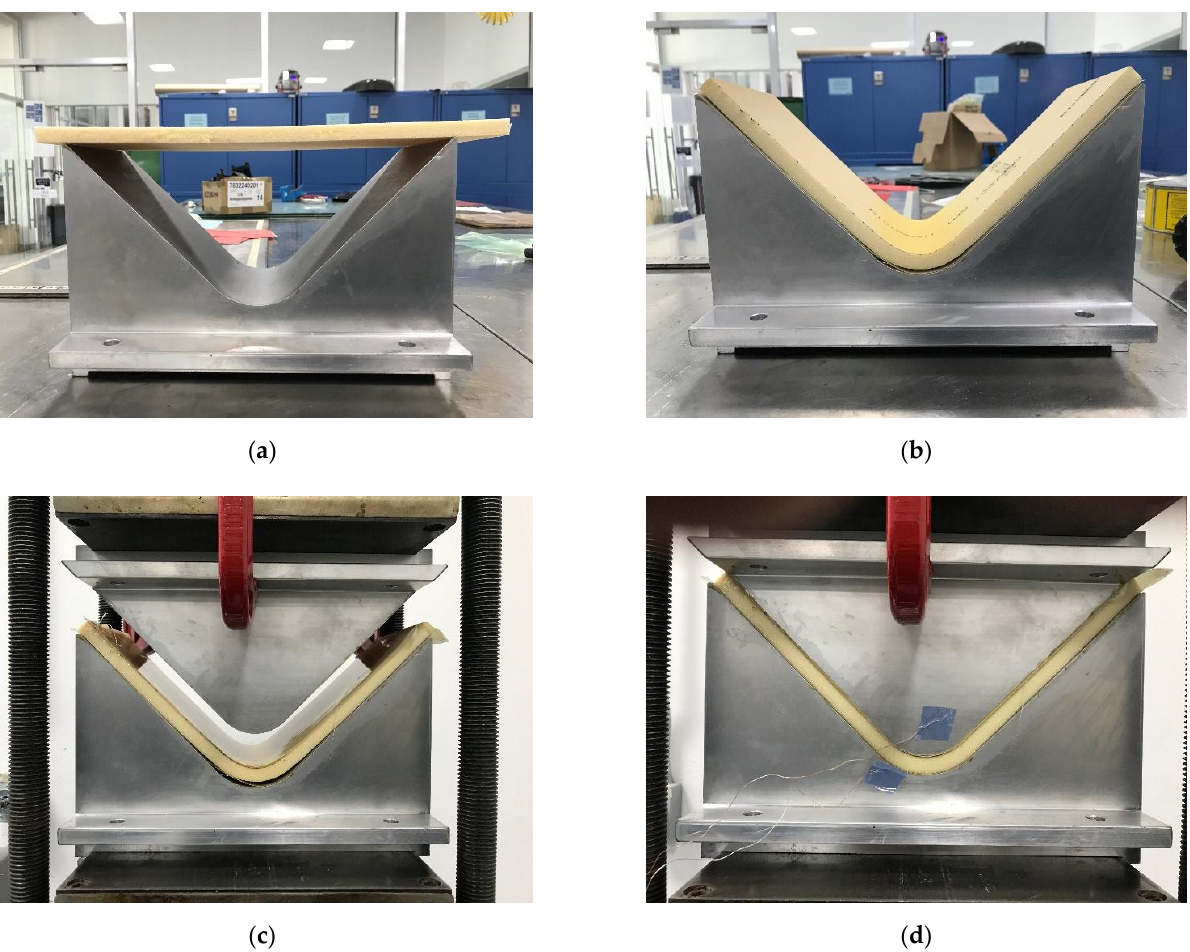
Figure 3. Schematic representation of the V ‐ shaped mold to produce composite sandwich panels: ( a ) Two layers of GF prepreg (step two), ( b ) HC placement (step three), ( c ) complete sandwich structure (step three), ( d ) preheated process (step four), ( e ) manufacturing of V ‐ shaped panel (step five), and ( f ) digital rendering of the V ‐ shaped mold.